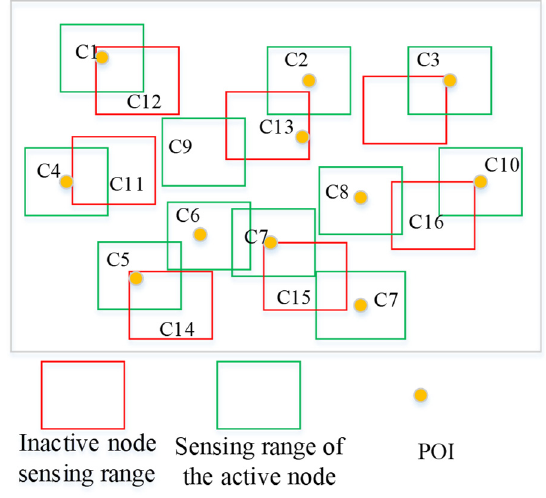
Figure 4. Wireless sensor network coverage with 16 active nodes.